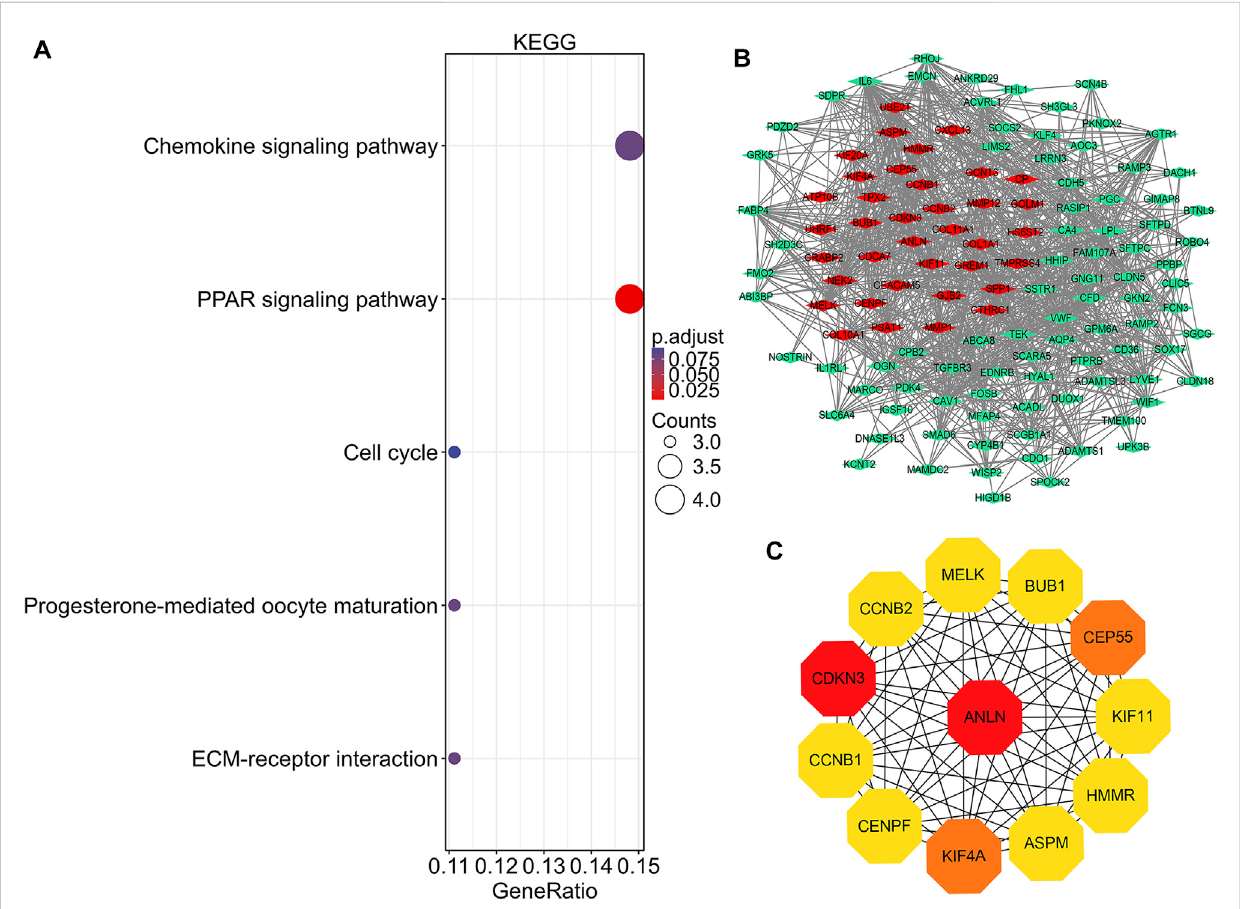
FIGURE 4 KEGG pathway analysis, protein-protein interaction network construction, and module analysis. (A) Signi fi cantly enriched KEGG pathway terms of DEGs in NSCLC. (B) DEGs protein – protein interaction network complex. Red nodes refer to upregulated genes. Green nodes refer to downregulated genes. Edges represent protein-protein associations. (C) Top 12 key genes with high connectivity in the network. The shade of the color indicates the strength of the connection. NSCLC, non-small cell lung cancer; DEG, differentially expressed